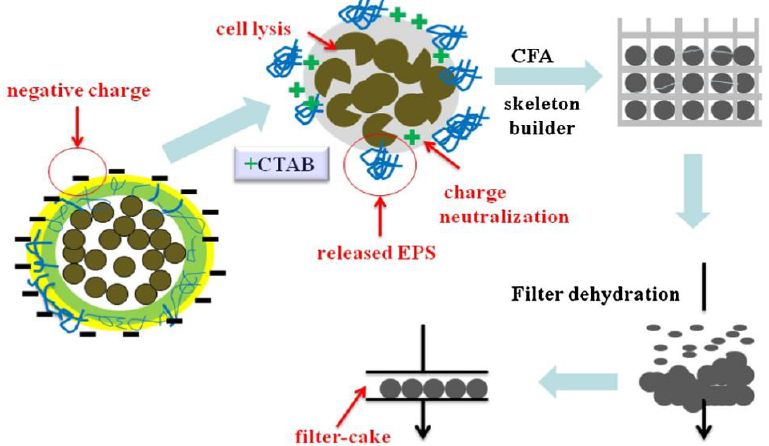
Figure 7. Mechanism proposed by Zheng et al. [28] for the flocculation of the anaerobic digestate by adding a cationic surfactant (CTAB) and subsequent filtration using CFA to improve the drainage of the filter cake to achieve the dewatering. The CTAB neutralized the surface charges of the flocs of the anaerobic digestate and enabled the release of the hydrated extracellular polymeric substances (EPS). The CFA acted as a skeleton builder of the filter cake and enhanced the physical solid-liquid separation by decreasing the compressibility of the filter cake. Reprinted with the permission of Separation and Purification Technology